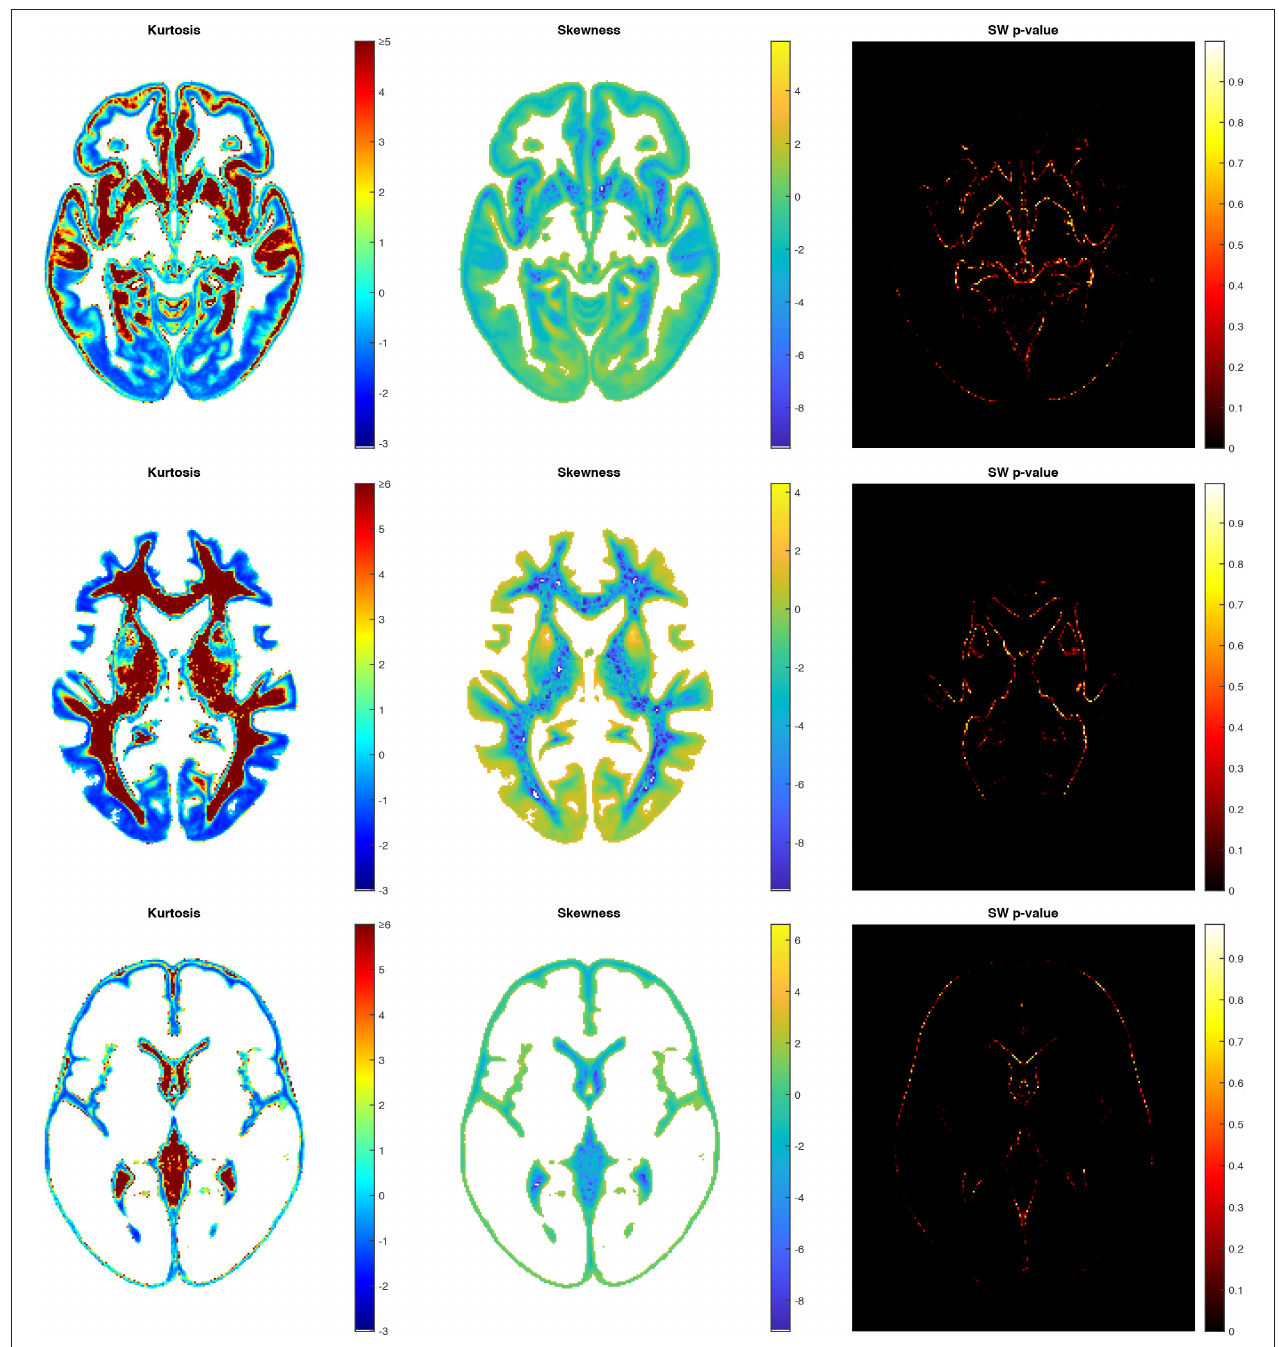
FIGURE 6 | Axial slices of the kurtosis, the skewness and the Shapiro-Wilk test p -value map for GM (top) , WM (middle) , and CSF (bottom)